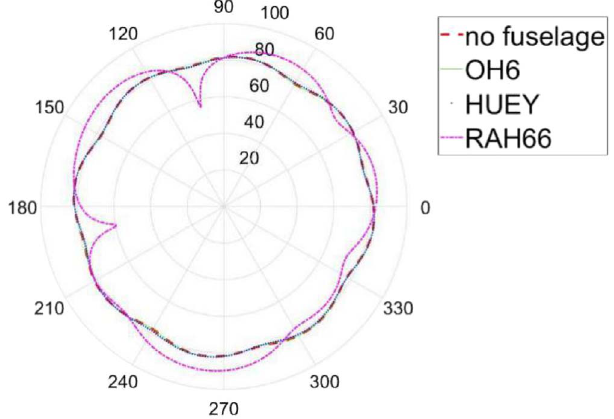
Figure 7. Scattering effects of different types of fuselage (polar